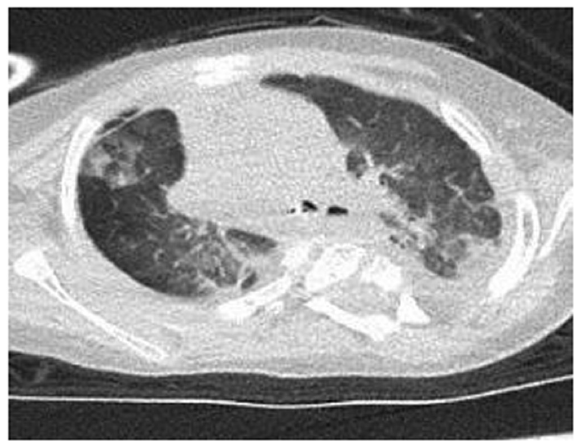
Figure 2. High-resolution computed tomography (HRCT) of a 3-year-old girl with VACTERL association, epilepsy, cognitive/motor delay, and COVID-19 pneumonia: Areas of complete/incomplete consolidation with sporadic air bronchograms in bilateral lung parenchyma and ground-glass opacities in the bilateral lung parenchyma. COVID-19: coronavirus disease 2019.